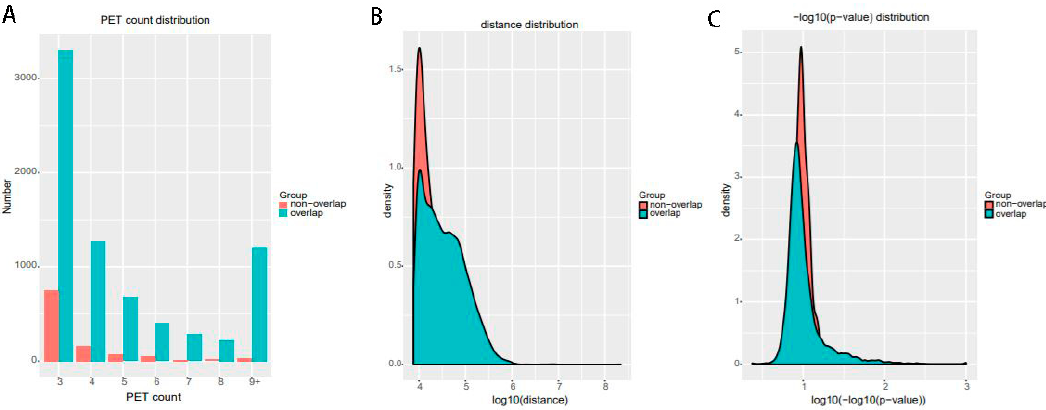
Figure 14. The interactions of ChIA-PET Tool V3 which are overlapped with those from ChiaSig and the interactions which are not overlapped with those from ChiaSig on ( A ) PET count, ( B ) genomic distance between two anchors and ( C ) –log( p -value).